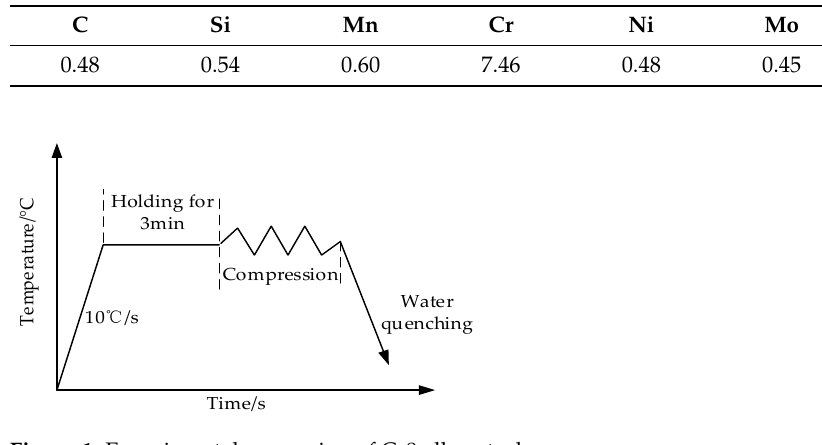
Figure 1. Experimental processing of Cr8 alloy steel.